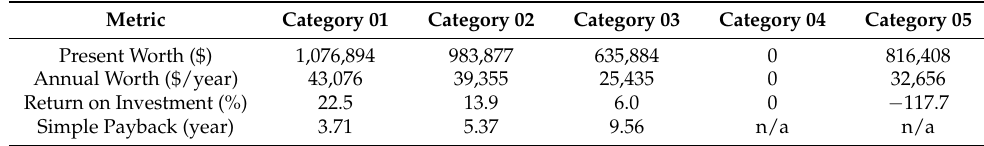
Table 6. Economic comparison of proposed five categories of